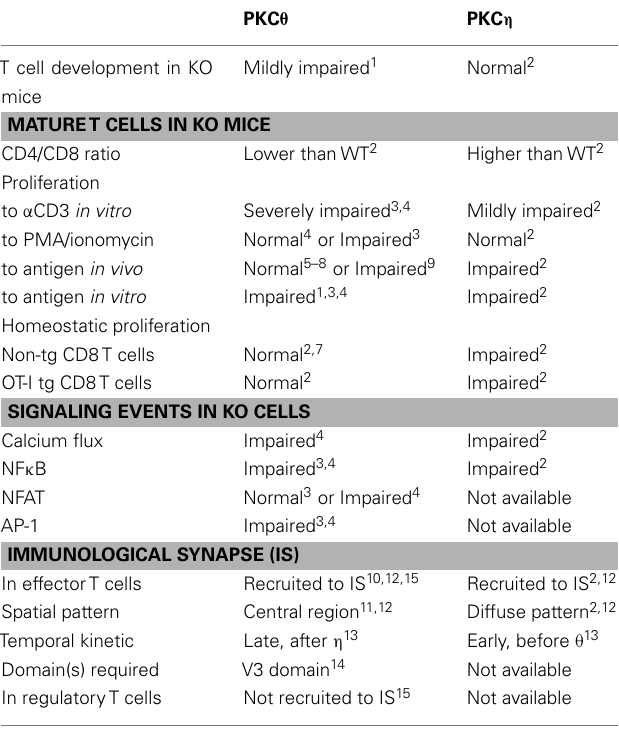
Table 1 | Comparison of PKC η and PKC θ inT cell